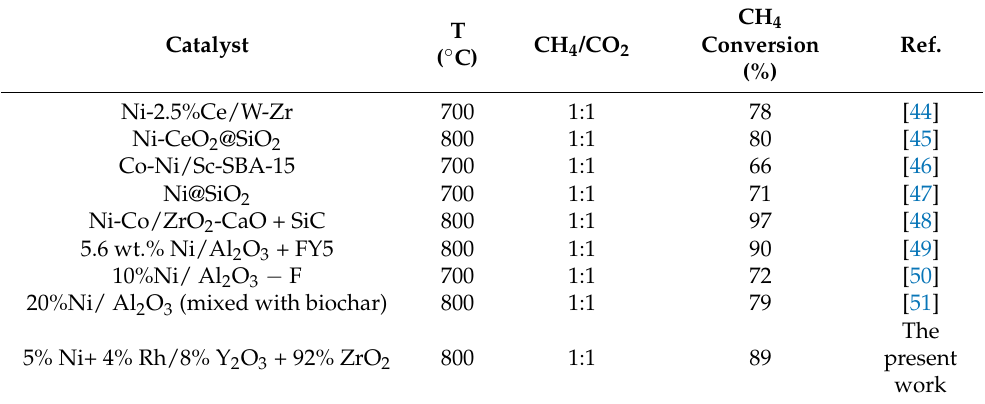
Table 4. Catalytic performance of new method compared to previous works for the dry reforming of